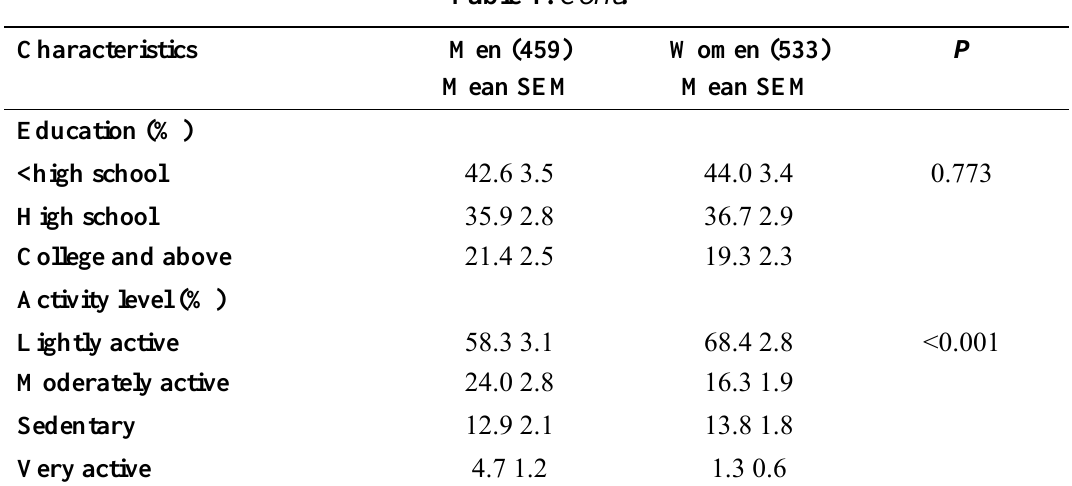
Figure 1. Distribution of BMI by gender in Kuwaiti adults.